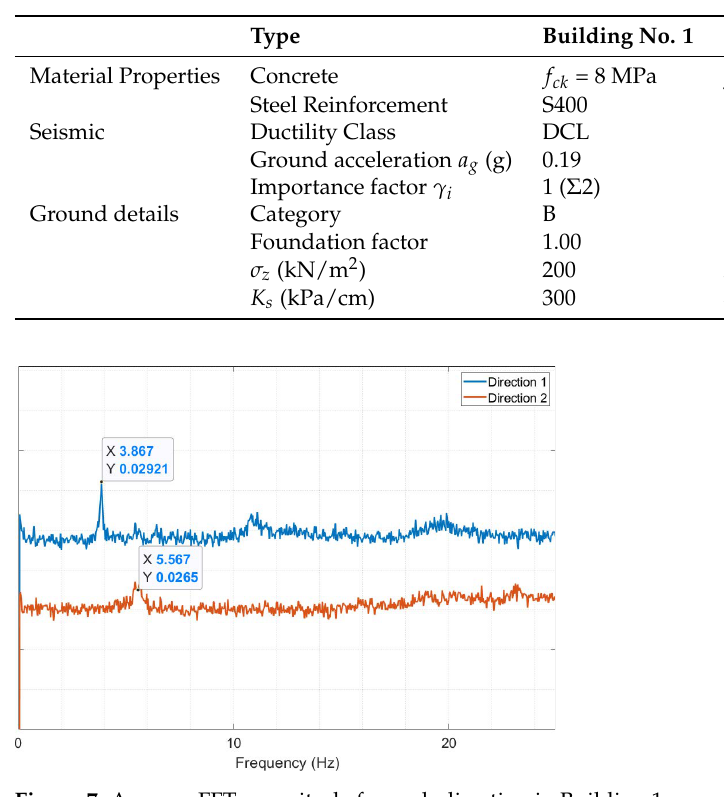
Figure 7. Average FFT magnitude for each direction in Building